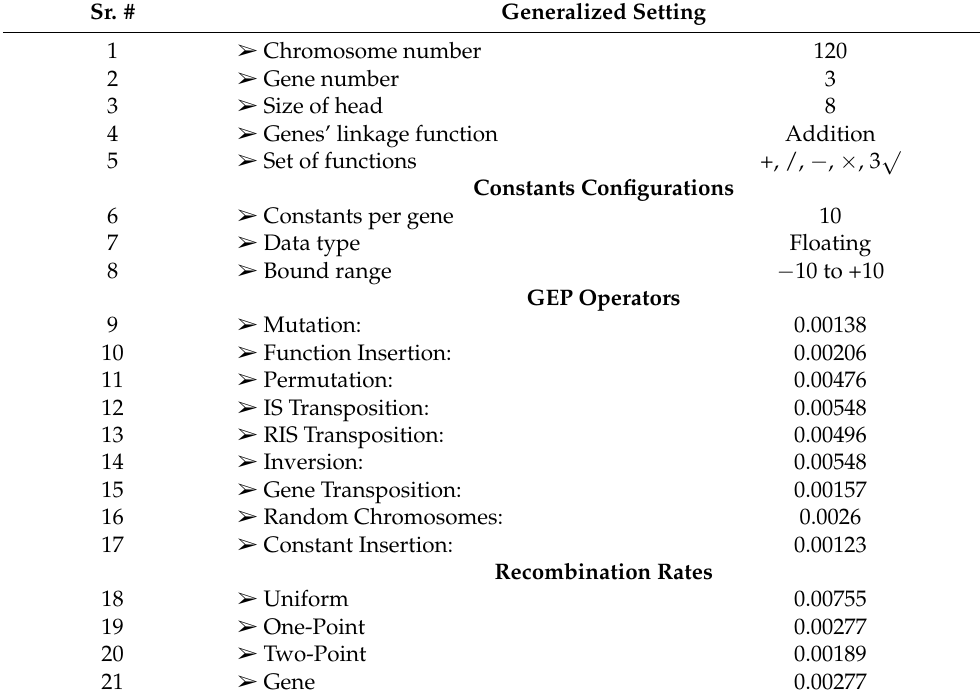
Table 1. Hyper parameters configuration incorporated for modeling. Sr.